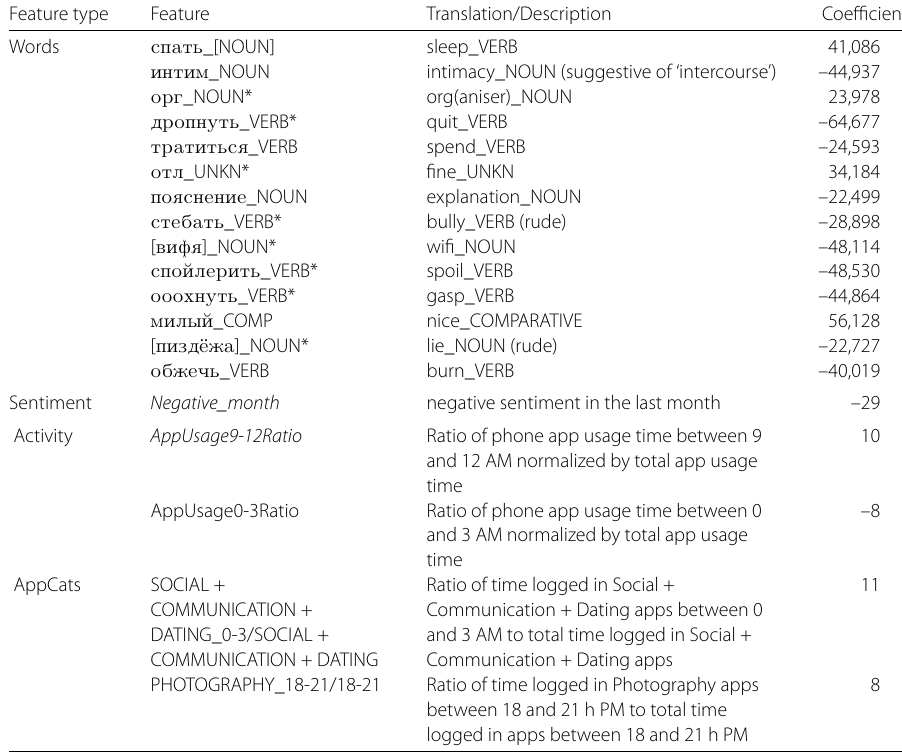
Table 10 Predictive features in SWLS scale. Slang, misspellings and unconventional word forms are shown with an asterisk (*). Errors in lemmatization are enclosed in brackets Feature